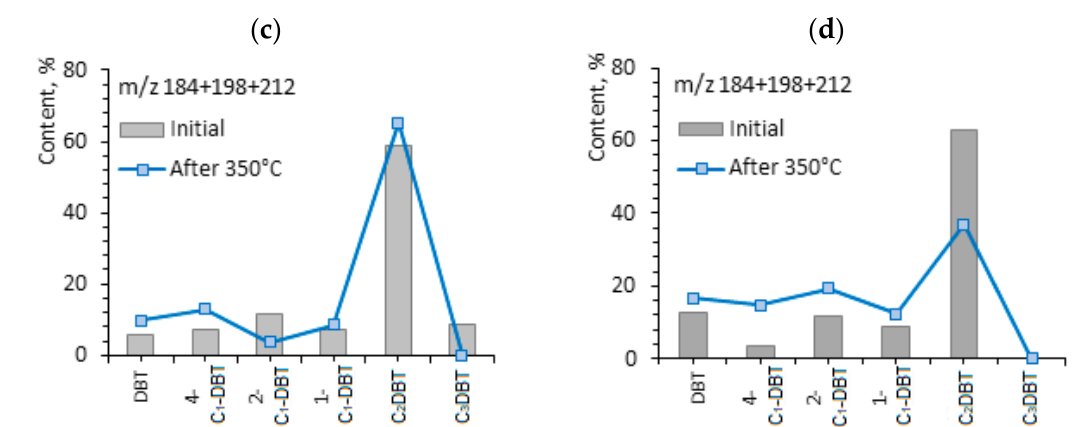
Figure 6. Molecular-mass distribution of aromatic organosulfur compounds: benzothiophene ( a , b ) and dibenzothiophene ( c , d ) in shale oil before and after hydrothermal experiments at 350 ° С .